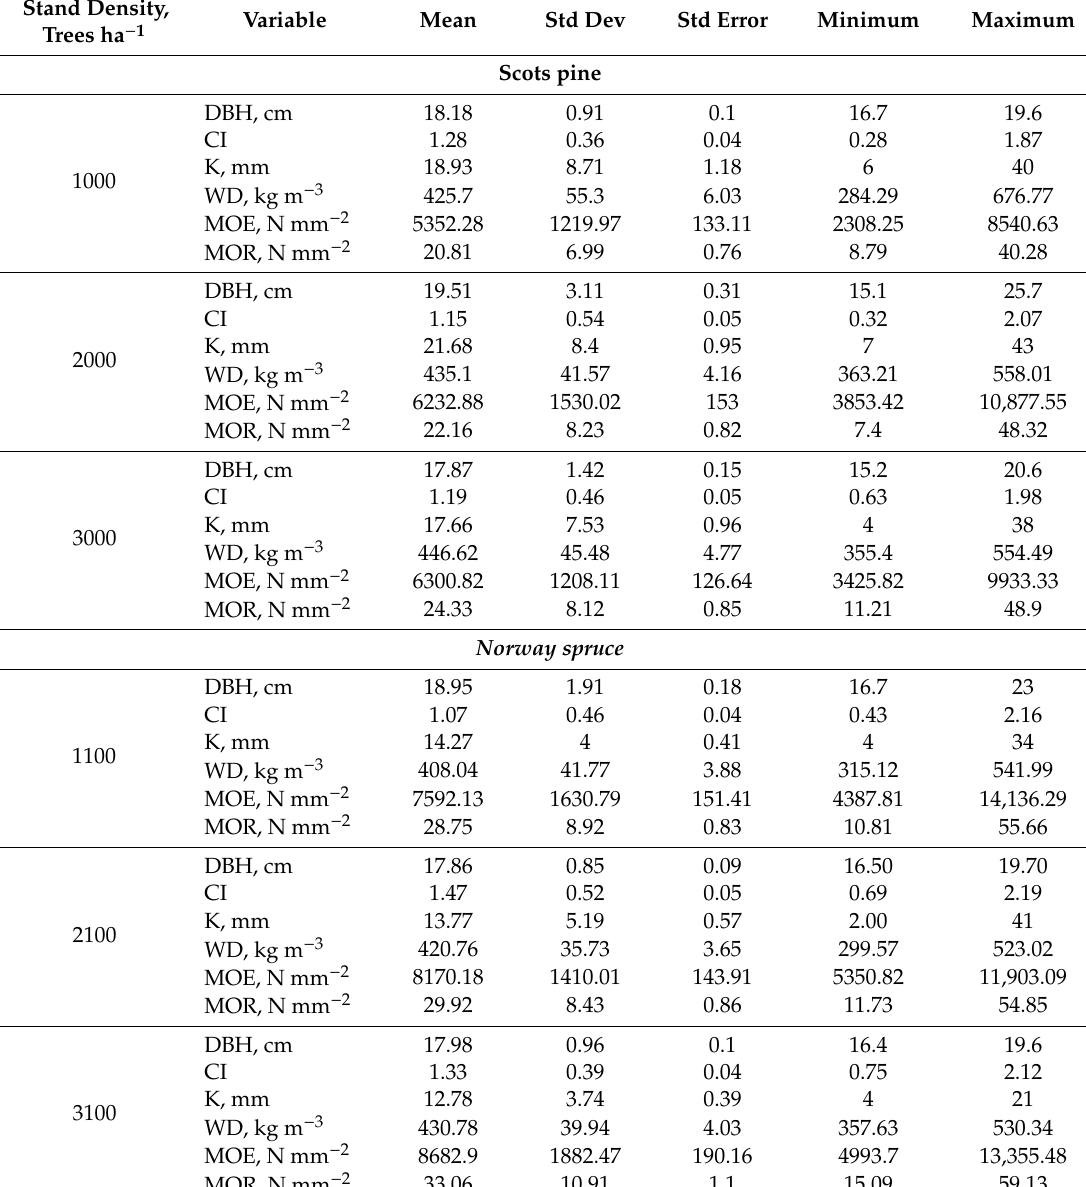
Table 2. Main characteristics, i.e., tree diameter at breast height (DBH), competition index between trees (CI), knot diameter (K), wood density (WD), global modulus of elasticity (MOE), and bending strength (MOR) of model Scots pine and Norway spruce trees at sites with di ff erent stand densities. Stand